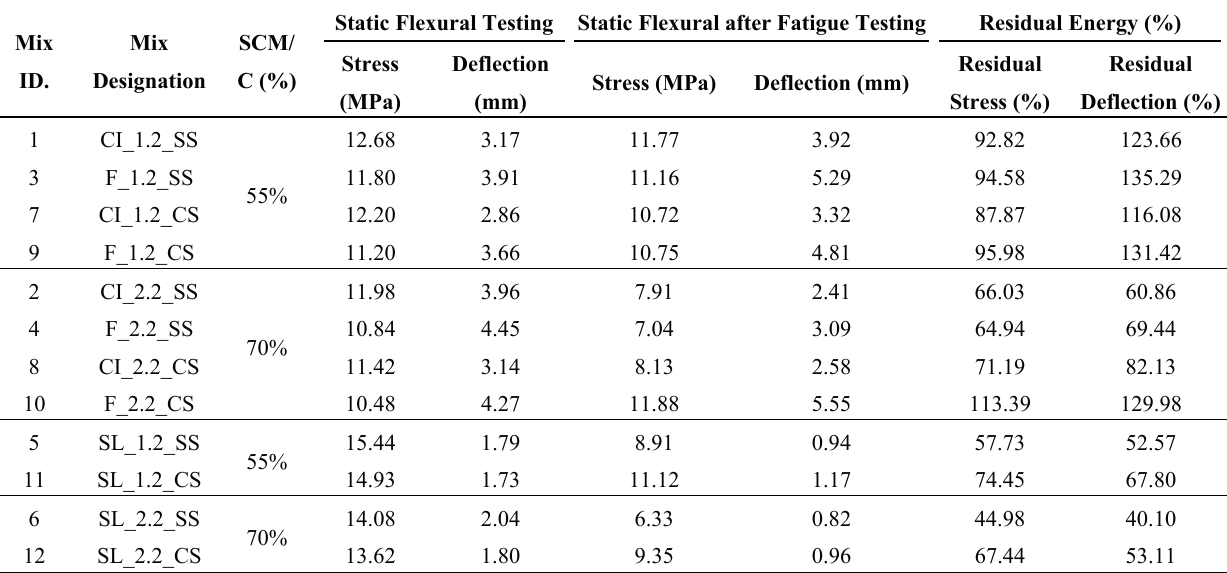
Table 5. Fatigue flexural test results (phase